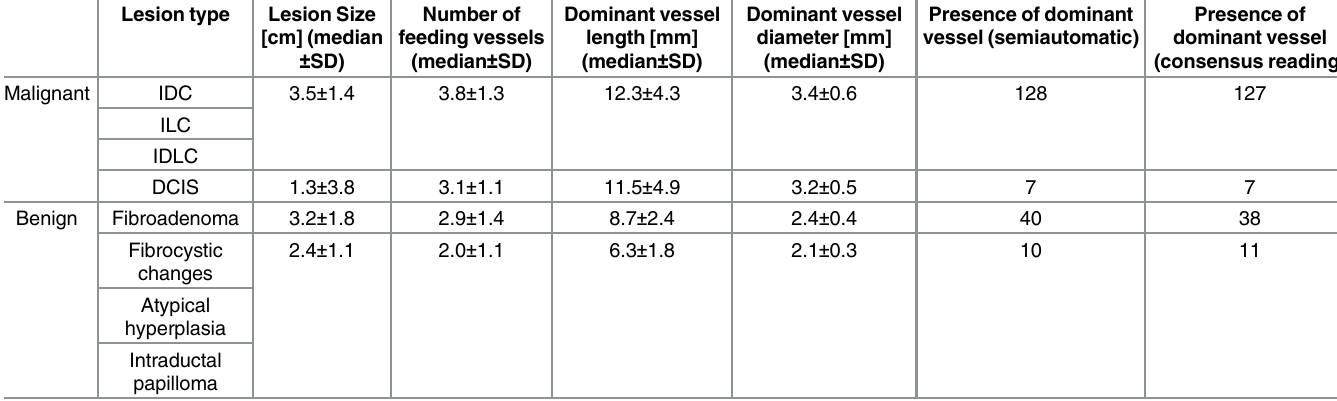
Table 4. Relationship between lesion subtype and size with dominant feeding vessels. The number of feeding vessels, the dominant vessel length and diameter were evaluated exclusively with the semi-automatic approach. Lesion